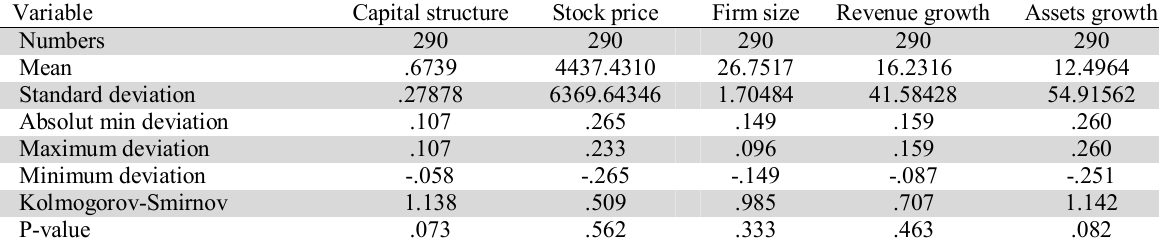
The summary of some basic statistics